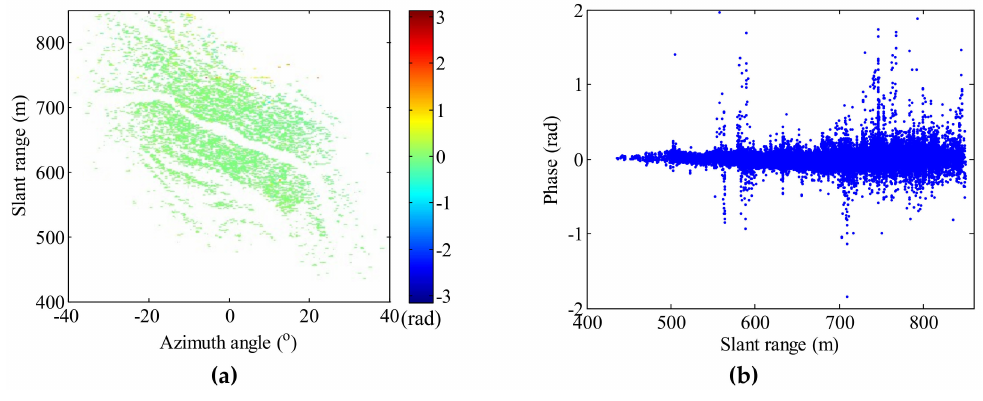
( 30 ) ( 30 ) : ( a ) CIM and ( b ) CSD A A